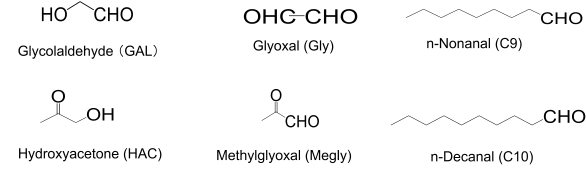
2 Experimental Mt. Tai (elevation: 1534 m above sea level, 36.25 ◦ N